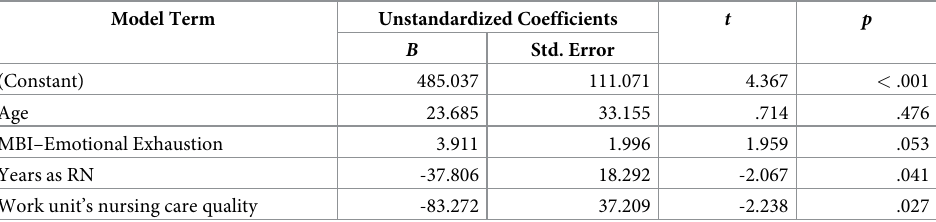
Table 7. Results of backward elimination multiple regression of potential predictors of total telomere length (n =